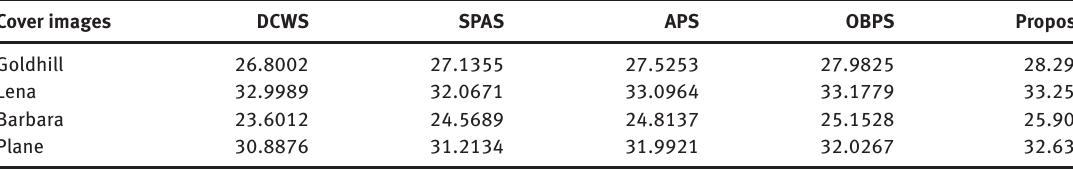
Table 1: PSNR Values of ST Using Cameraman as a Secret Image. Cover images